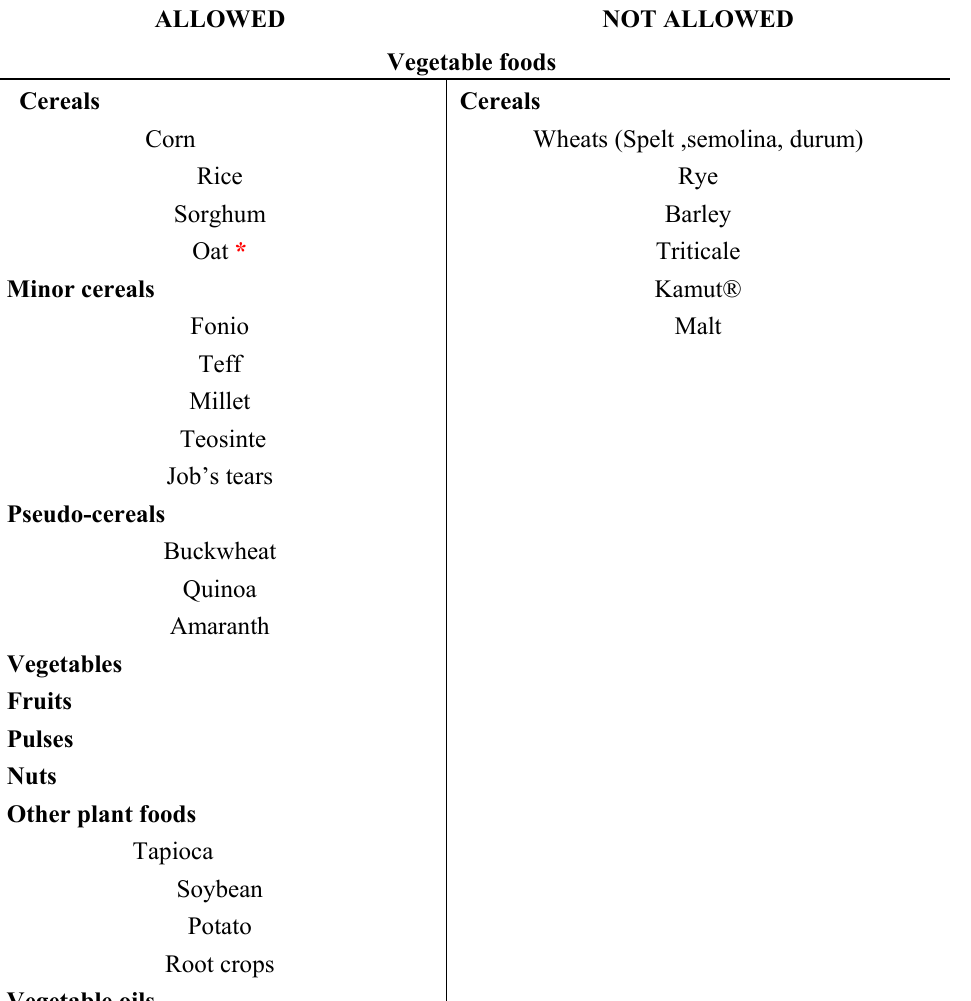
Table 2. Vegetable and animal foods allowed or not allowed in gluten-free